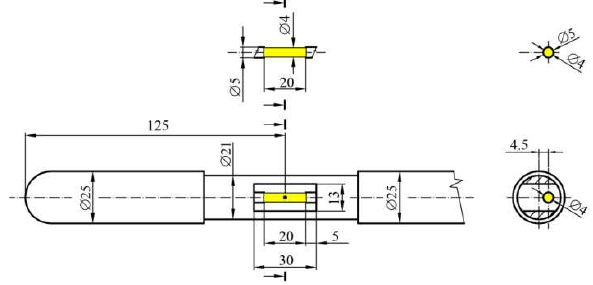
Fig. 4 . The modified shape design and dimensions of the extinction probe head – VarP2 .